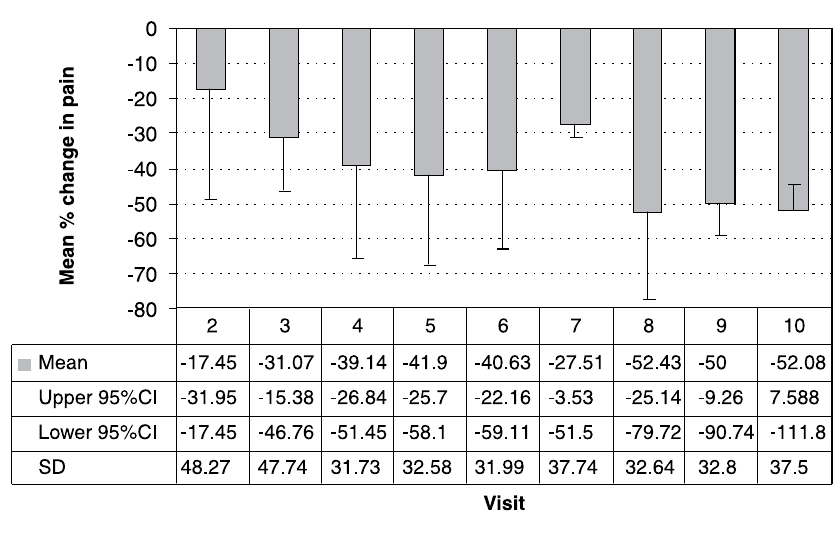
Figure 1: Mean pain change (% change) for momentary pain